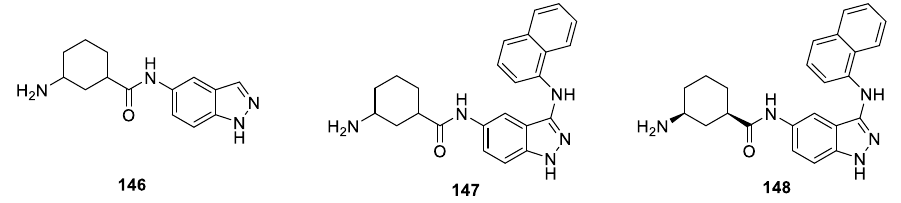
Figure 40. Chemical structures of 1 H -indazole derivatives 146 – 148.